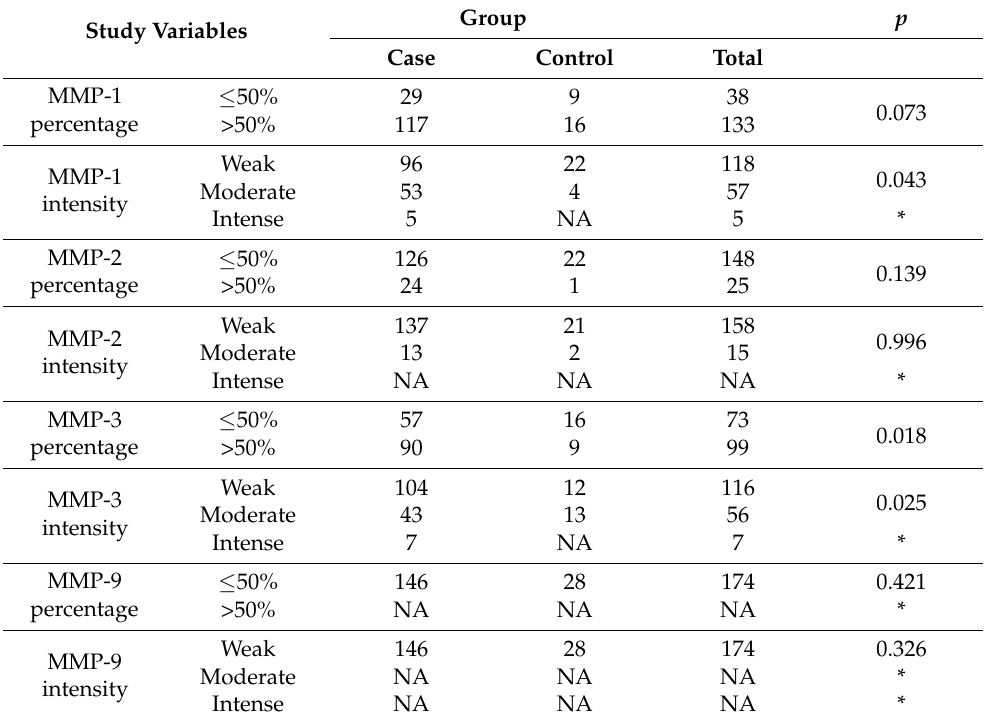
Table 2. Statistical analysis of interactions between MMP-1, MMP-2, MMP-3, and MMP-9 (percentage and intensity) and the variable groups (case and